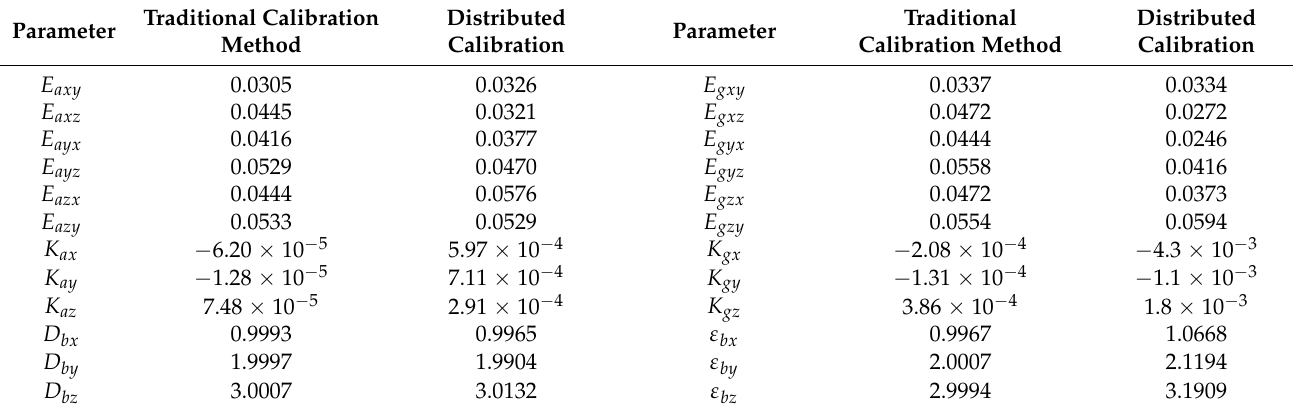
Table 2. Comparison of traditional and distributed calibration